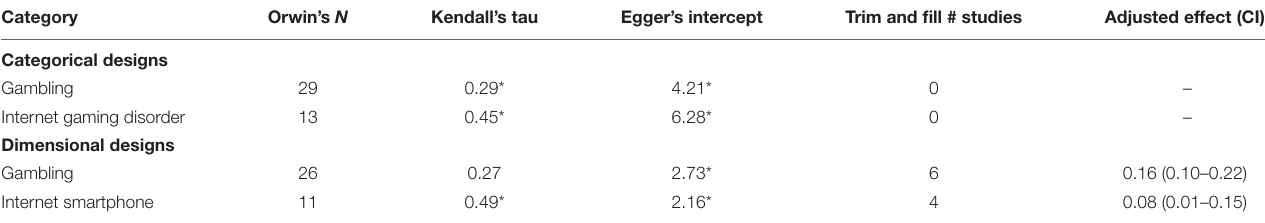
TABLE 2 | Publication bias